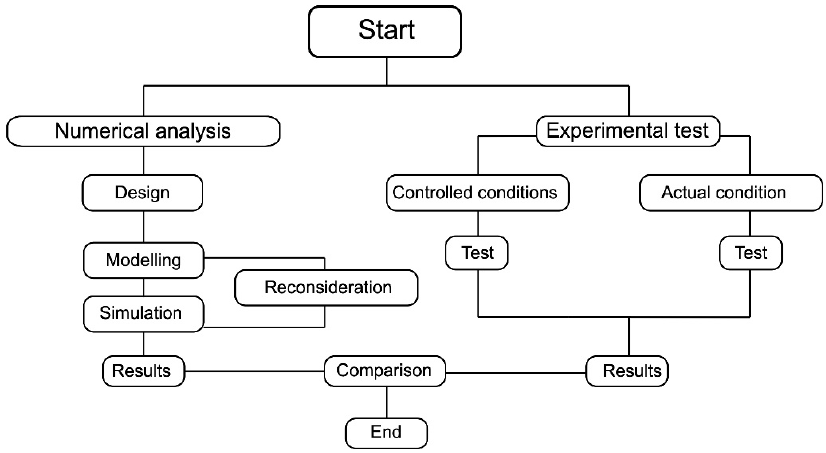
Figure 1. Procedures used in this study.